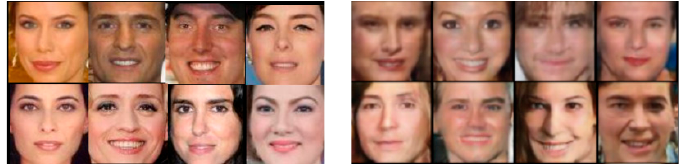
Figure 4. Deep-network-generated face image (left: 128 × 128 and right: 64 × 64).